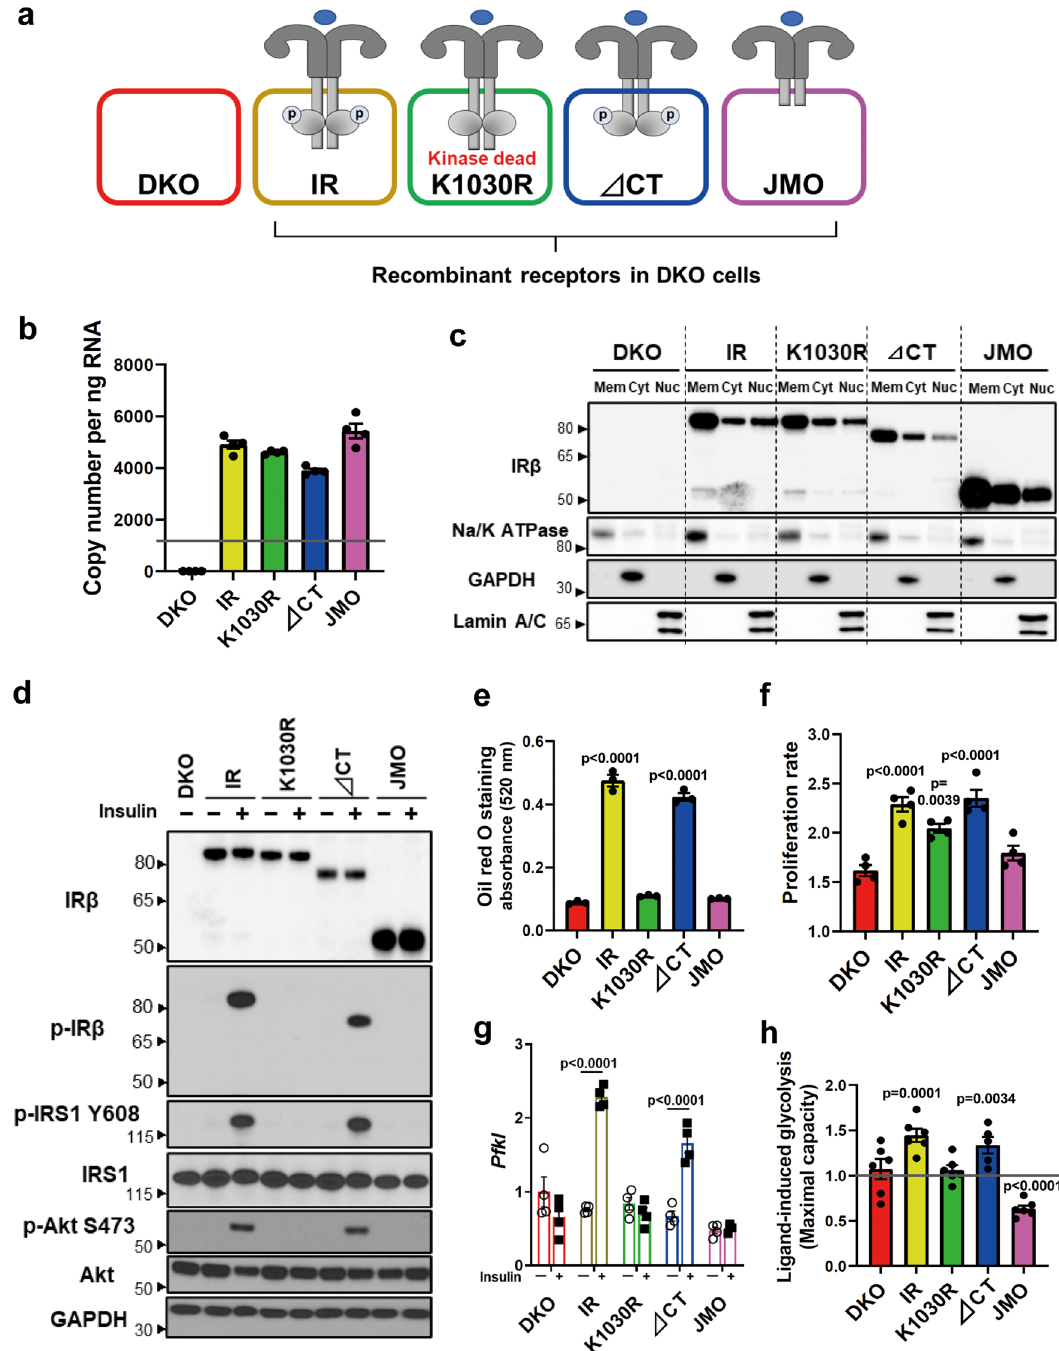
Fig.1|Kinase-anddomain-dependentrolesofIRinregulatingmetabolismand growth. a Schematic representation of DKO preadipocytes reconstituted with